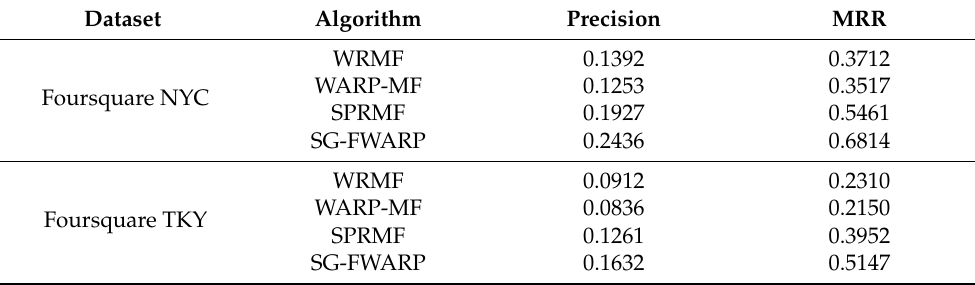
Table 3. Performance comparison on top-10 route